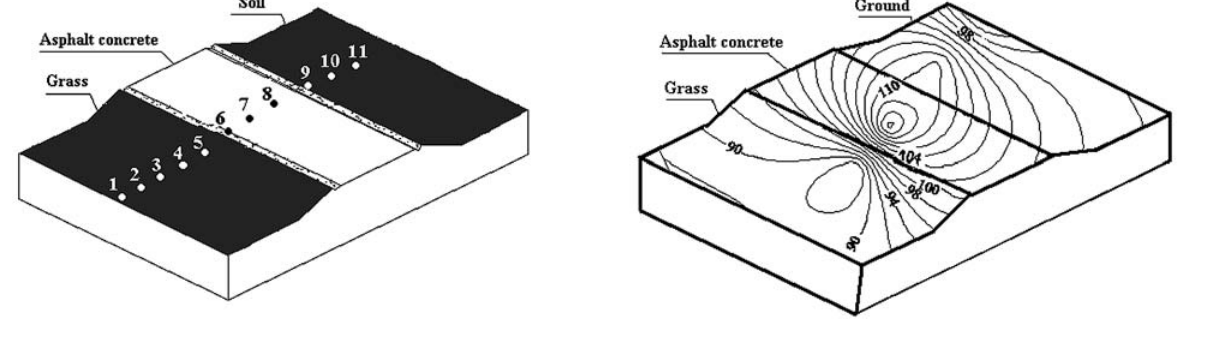
Fig. 1. Scheme of mesurement places of EDR above pavement of highway and its sides